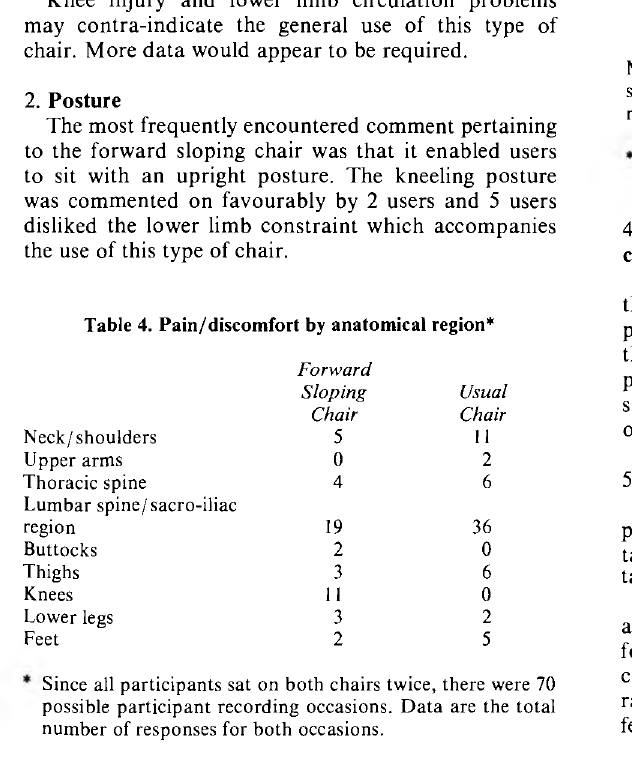
Table 5. Analysis of discrepancies between user anthropometry and corresponding workspace dimensions*